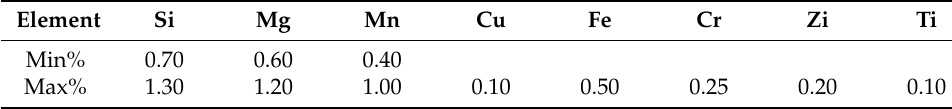
Table 1. Chemical composition of the investigated EN-AW6082 aluminium alloy. Element